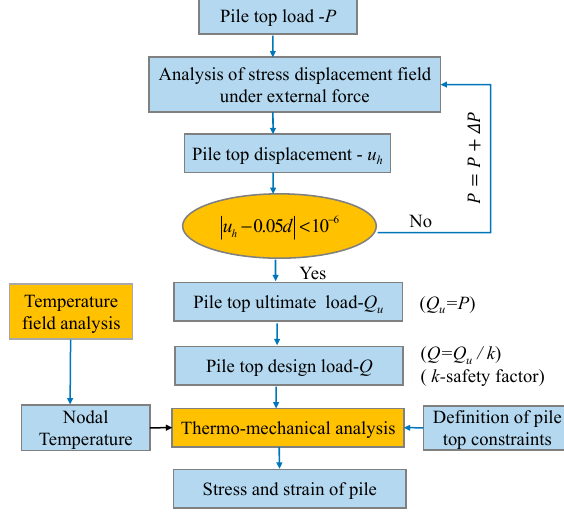
Figure 2. Modeling process.